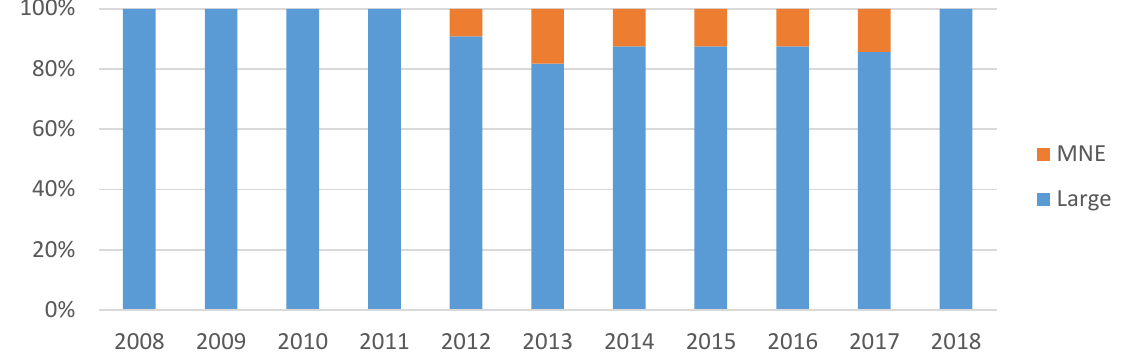
Figure 2. SR in Ukraine for the period of 2008–2018 by the companies’ size